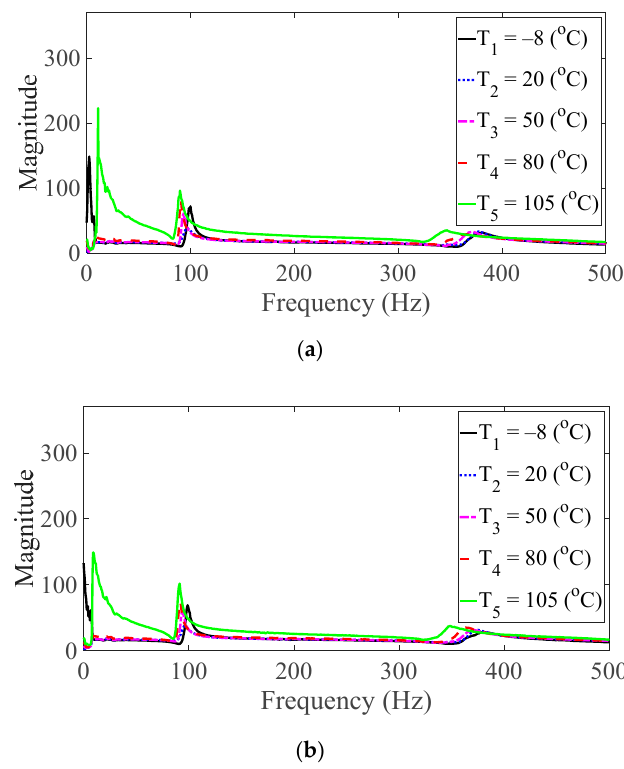
Materials 2019 , 12 , x Figure 7. Measured FRFs with θ = 45°: ( a ) p = harmonic and ( b ) p = random. Figure 7. Measured FRFs with θ = 45 ◦ : ( a ) p = harmonic and ( b ) p = random.